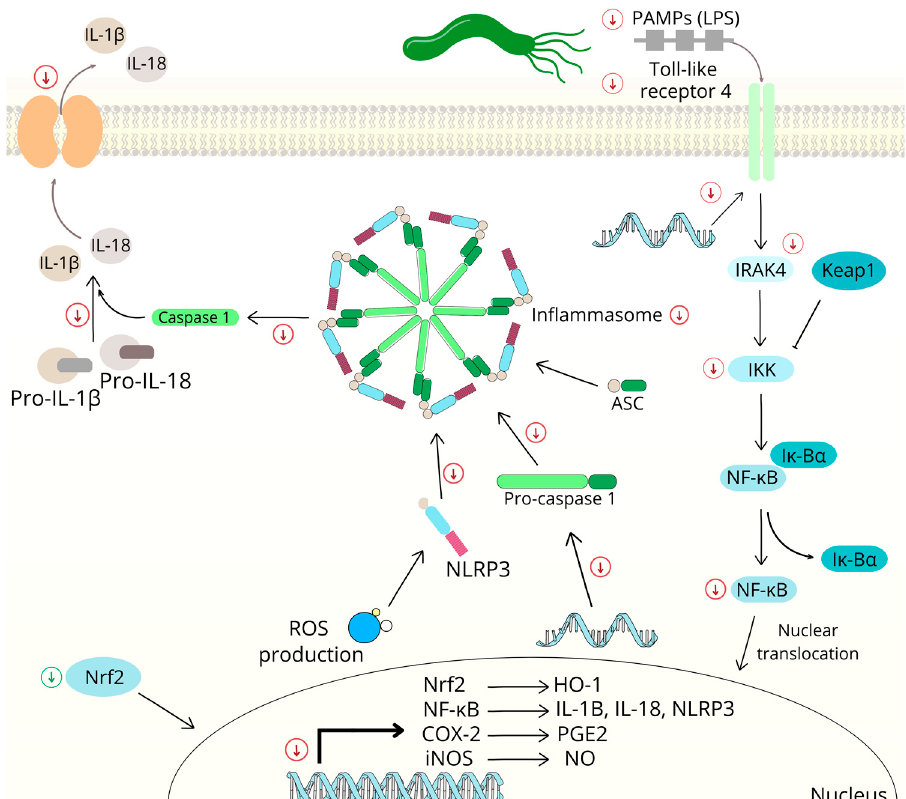
Figure 4. Effect of chalcones inflammation and H. pylori infection. Abbreviations: ASC—apoptosis- associated speck-like protein containing a CARD, COX-2—cyclooxygenase-2, HO-1—heme oxygenase